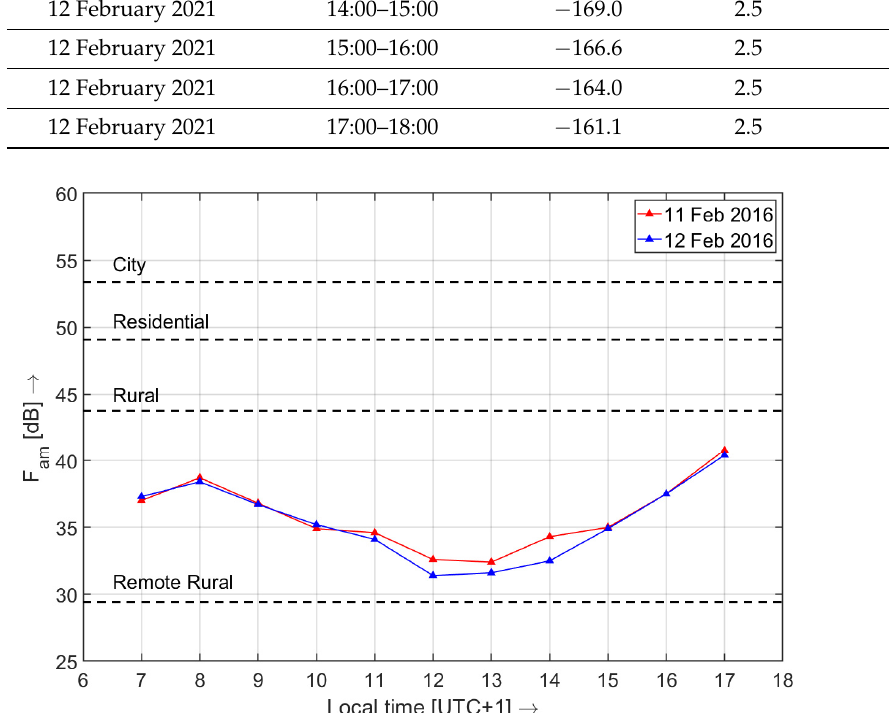
Figure 13. The median ambient noise factor F am , calculated from the measurements for each hour of the observations, show the diurnal variation of the noise. The predicted values from Recommendation ITU-R P.372-15 are shown as horizontal dashed lines.